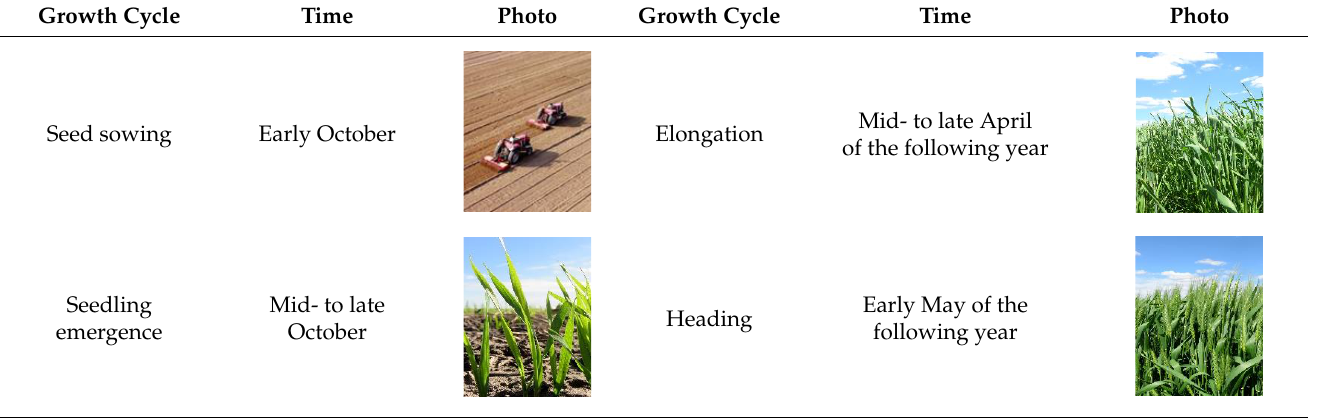
Table 1. Primary winter-wheat growth cycles in the study area.